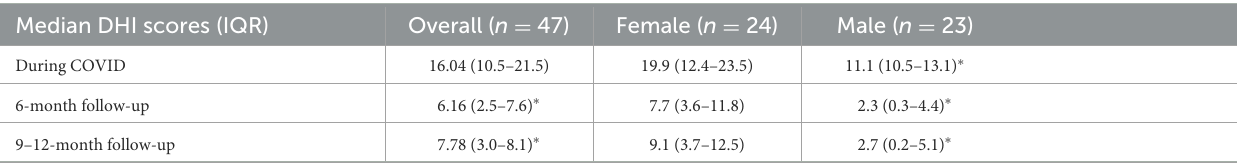
TABLE 2 DHI results during and after COVID-19: median DHI scores and IQR are shown.